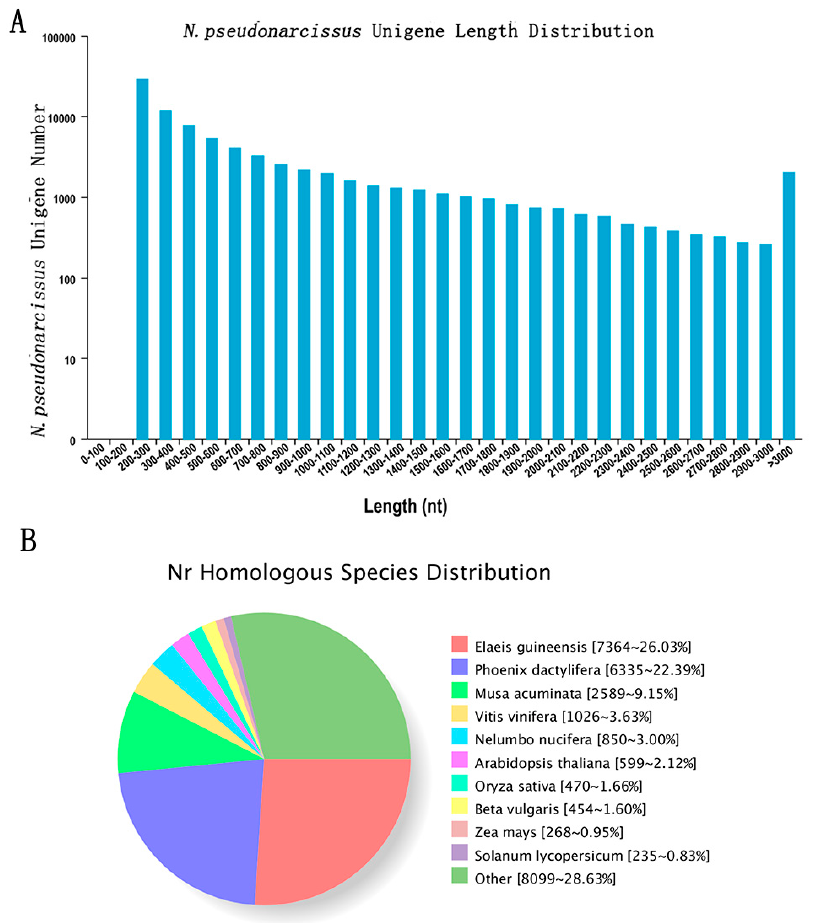
Figure 3. The N. pseudonarcissus sequence length distribution and Nr homologous species distribution. ( A ): The sequence length distribution of assembled unigenes. The horizontal axis represents the sequence length of base pairs and vertical axis represents the number of assembled unigenes in the range of the sequence length. ( B ): Species distribution of the top BLAST hits.